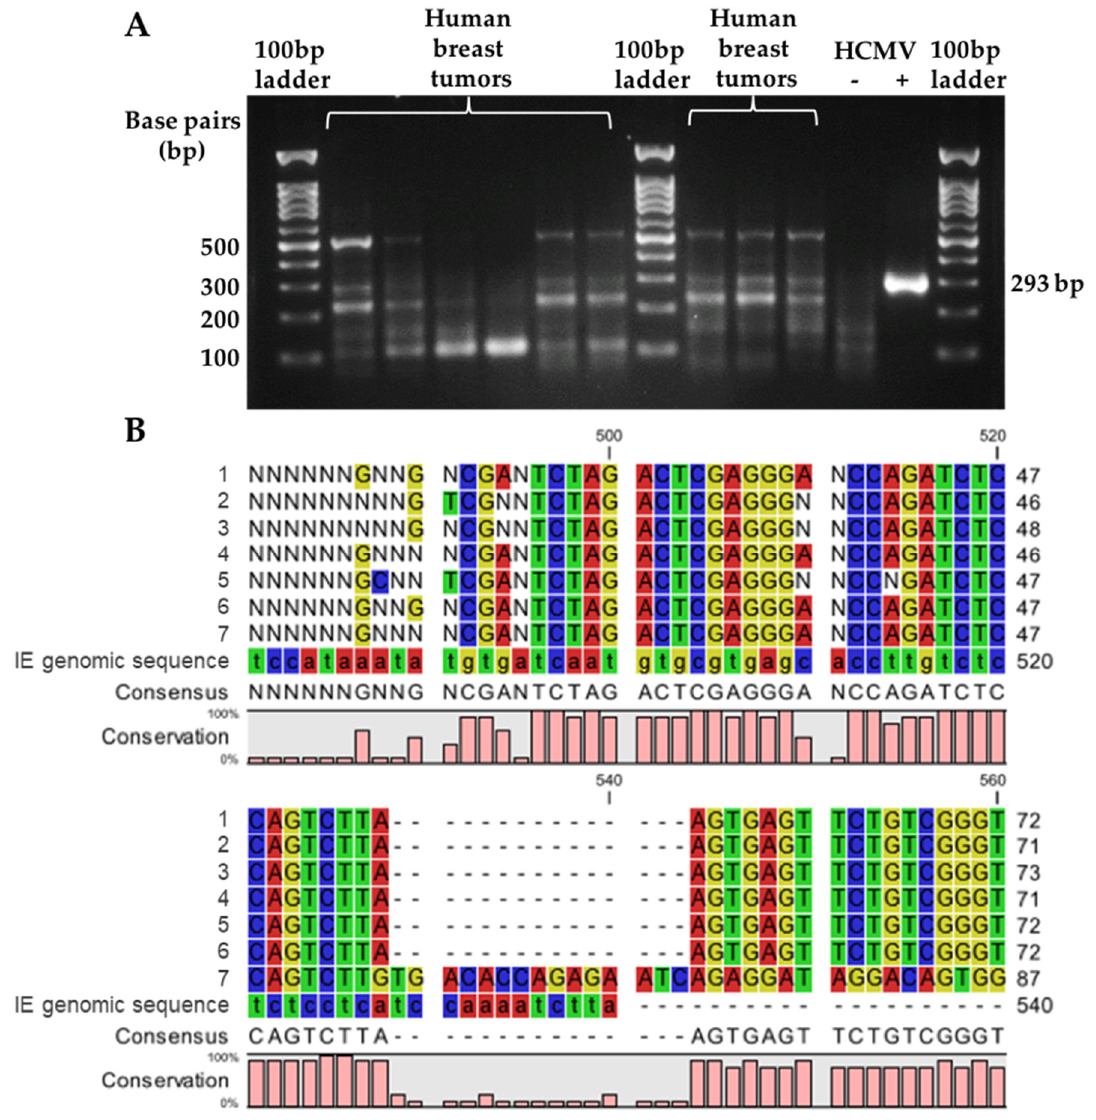
Figure 3. Specificity of HCMV immediate early 1 (IE1) DNA detection using nested PCR. PCR products for amplified HCMV IE1 gene from human breast tumor samples were visualized on 1.5% agarose gel stained with ethidium bromide, resulting with a band at 293 base pair (bp) in the positive control ( A ). The PCR product at the 293 bp position was re-extracted from the gel for Sanger DNA sequencing, with the results aligned to the HCMV IE1 genomic sequence ( B ). Seven samples were analyzed and illustrated in the sequence alignment map ( B ).